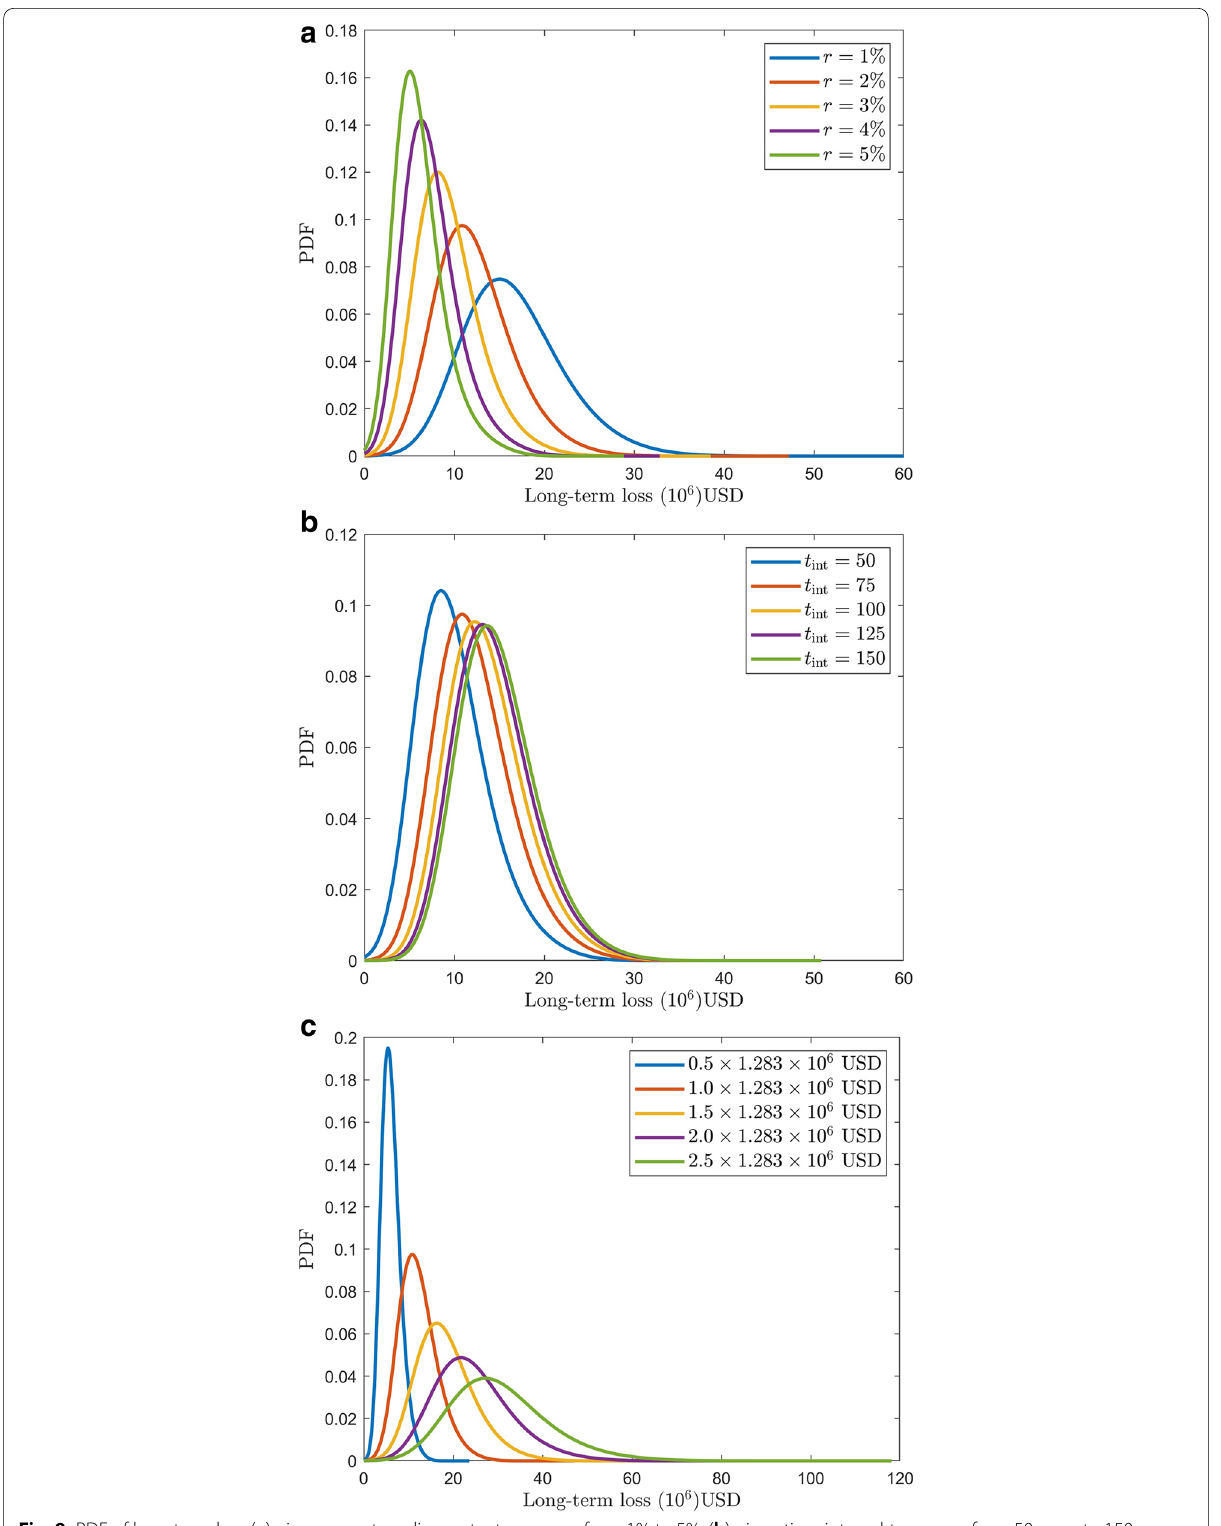
Fig. 9 PDF of long term loss ( a ) given monetary discount rate r ranges from 1% to 5%, ( b ) given time interval t int ranges from 50 years to 150 years and ( c ) given expected loss severity ranges from 0.5